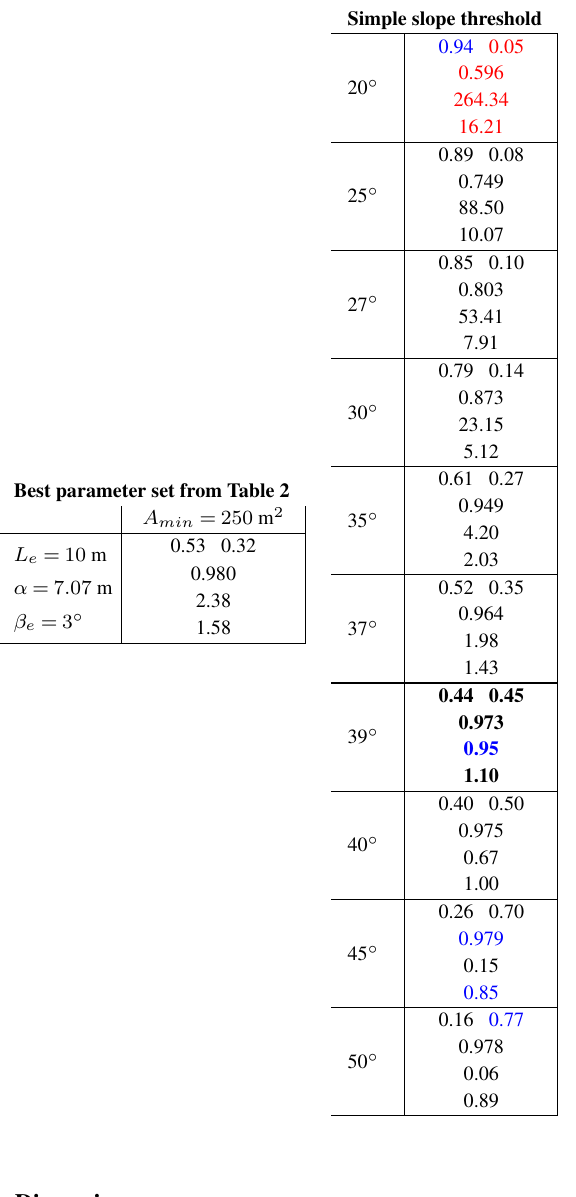
Table 3. Statistical measures of performance for Ngozumpa Glacier. The arrangement of metrics in each box, bold font and coloration are the same as in Table 2.